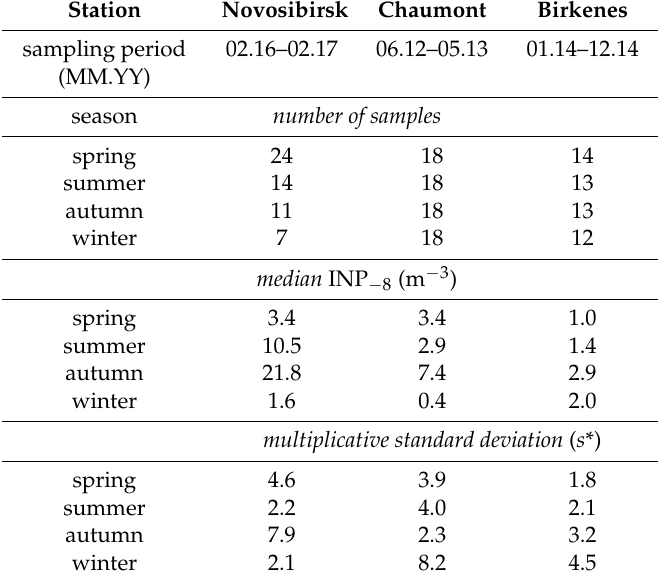
Table 1. Seasonal summary of the data shown in Figure 4. Seasons are defined following the meteorological convention: Spring begins on 1 March, summer on 1 June, autumn on 1 September, and winter on 1 December. The multiplicative standard deviation ( s *) is justified by the multiplicative processes driving the abundance of biological particles in the atmosphere [22,23]. We can estimate s * from the upper ( q 3) and lower ( q 1) quartiles of a distribution as ( q 3/ q 1) 0.741 [22]. Together with the geometric mean (or the median), the interval of confidence is indicated (68.3%: from median/ s *